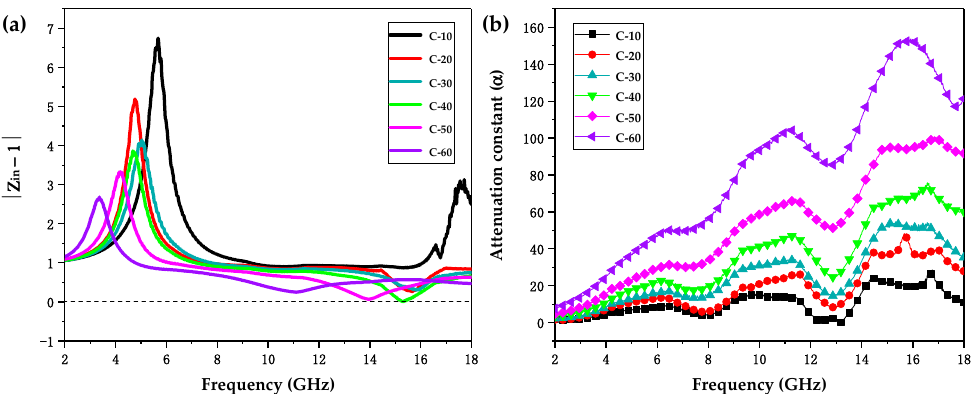
Figure 3. ( a ) The | Z in − 1 | values of samples C-10, C-20, C-30, C-40, C-50, and C-60 at the optimal thickness corresponding to RL-min in the frequency range of 2–18 GHz. ( b ) The attenuation constant α of samples C-10, C-20, C-30, C-40, C-50, and C-60 in the frequency range of 2–18 GHz.